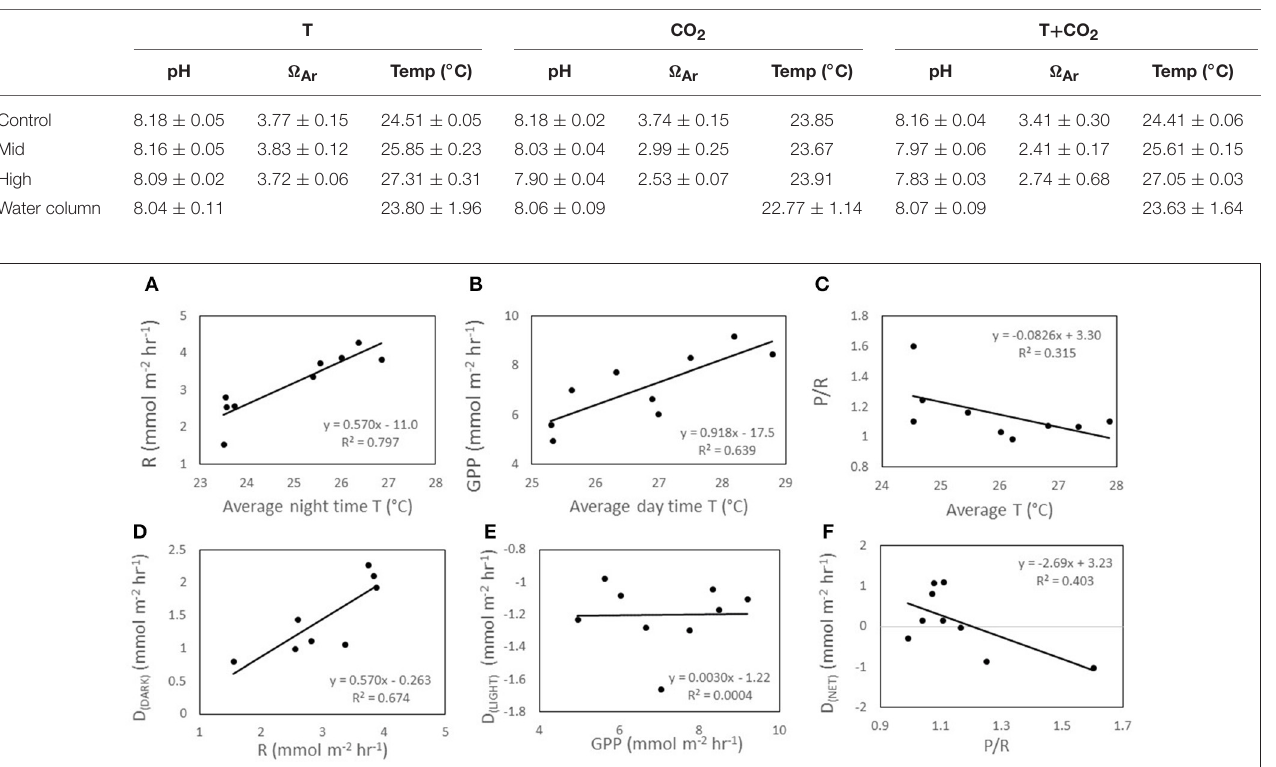
FIGURE 2 | Data from temperature only incubation (A) a regression between the average night time temperature within each chamber and R, (B) regression between average day time temperature within each chamber and GPP, (C) and between average overall temperature within each chamber and P/R. (D) The regression between overnight rate of respiration (R) and night time carbonate sediment dissolution (D DARK ), (E) regression between gross primary productivity (GPP) and daytime dissolution (D LIGHT ), (F) and between net carbonate dissolution (D NET ) and the ratio P/R.